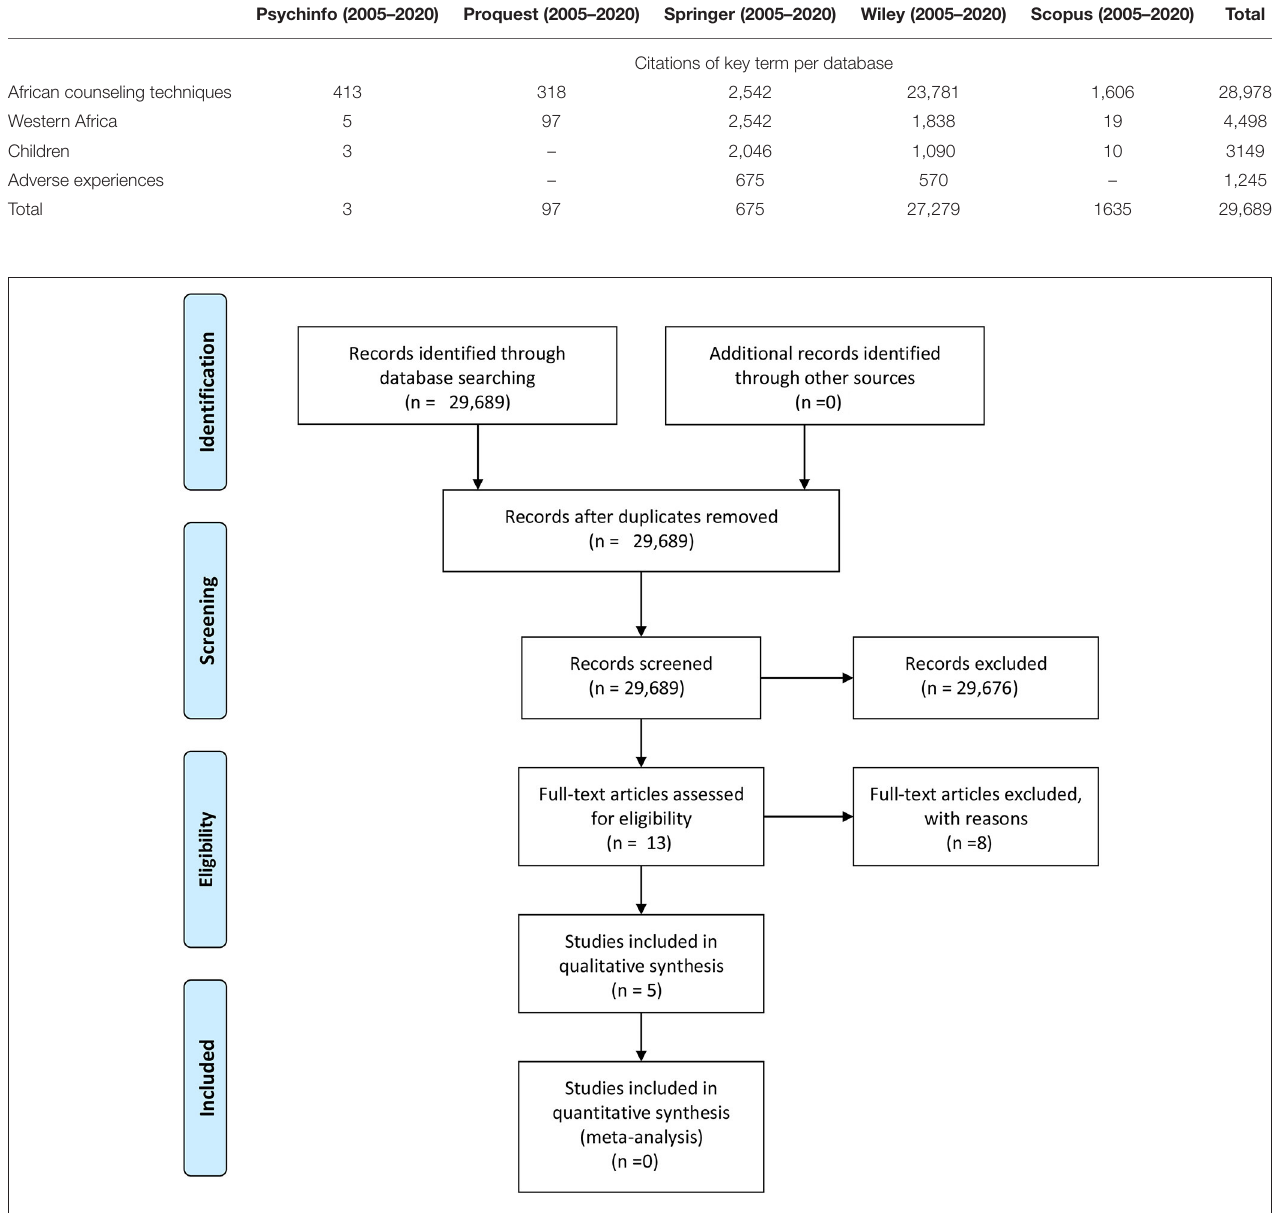
FIGURE 1 | Prisma flow chart for journal findings (Moher et al.,